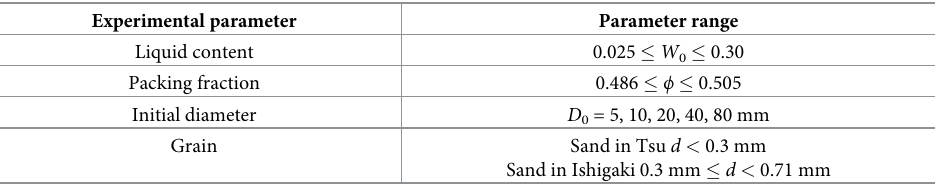
Table 2. Experimental parameters.